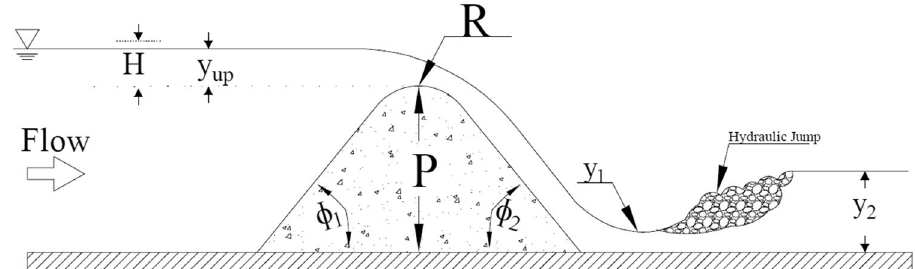
Fig. 1 The sketch of the circular crested weir and its hydraulic and geometric parameters